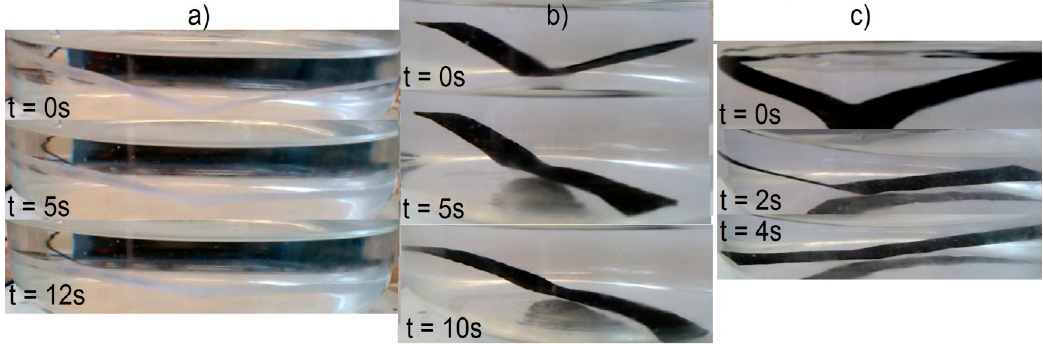
Figure 26. Shape recovery process for set III for materials: ( a ) MU1; ( b ) MU3 and ( c ) MU5.